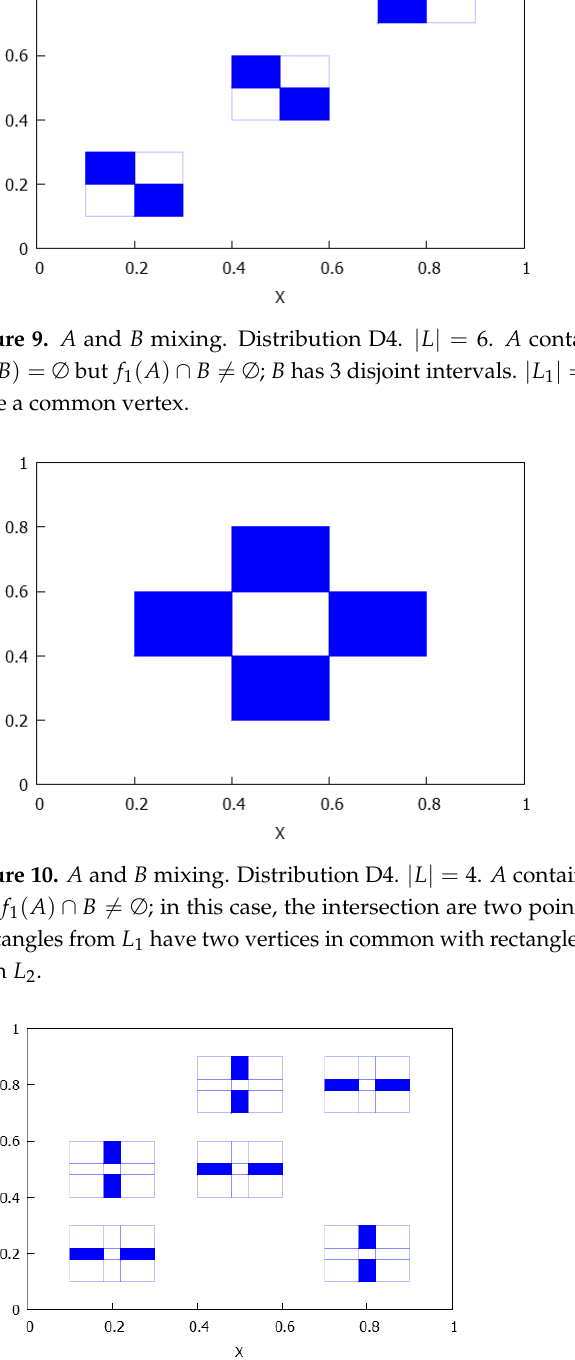
Figure 11. A and B mixing. Distribution D4. | L | = 12; A contains 3 intervals and f 1 ( A ) ∩ Int ( B ) = ∅ but f 1 ( A ) ∩ B (cid:54) = ∅ ; in this case, the intersection are two points but rectangles have no common points; B has 6 intervals; | L 1 | = | L 2 | =